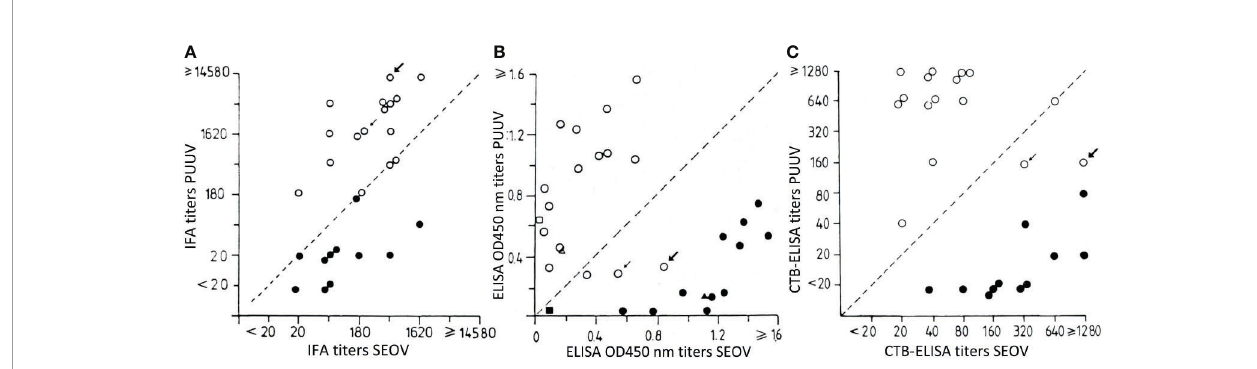
FIGURE 1 | IFA: immuno- fl uorescence assay or immuno- fl uorescence test (IFT). ELISA, enzyme-linked immunosorbent assay. CTB ELISA, complex-trapping blocking, an inhibition ELISA variant. Closed circles: 1980s laboratory rat-acquired human hantavirus infections. Open circles: non-laboratory rat-acquired or “ wild ” human hantavirus infections, mostly being 1980s PUUV-induced, except for two “ wild ” cases (arrows), being 1980s wild rat-induced SEOV infections. Thick arrow: Dutch farmer, thin arrow: Belgian homeless vagabond, both with wild rat-exposure. In these two cases, SEOV infection was missed in IFA, showing surprisingly high cross-reacting PUUV titers (A) , but con fi rmed, albeit with lower titers, in ELISA (B) , and unmistakably ascertained in CTB-ELISA (C) . Consequently, these two cases would have been mistaken for PUUV infections, if relying only on IFT/IFA. Adapted from Groen et al., 1991. Copyright © 1991 Wiley ‐ Liss, Inc., A Wiley